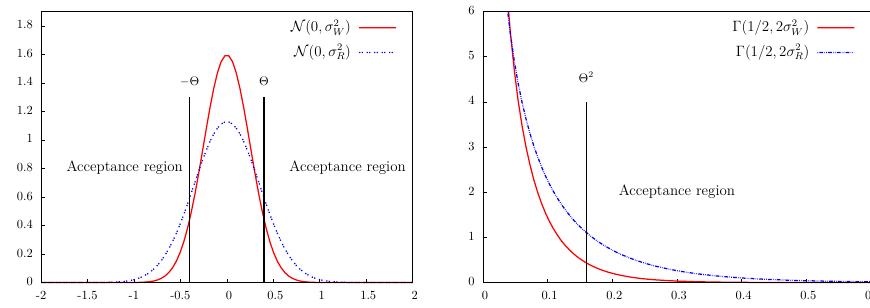
and ˆ c 2 . These are R W